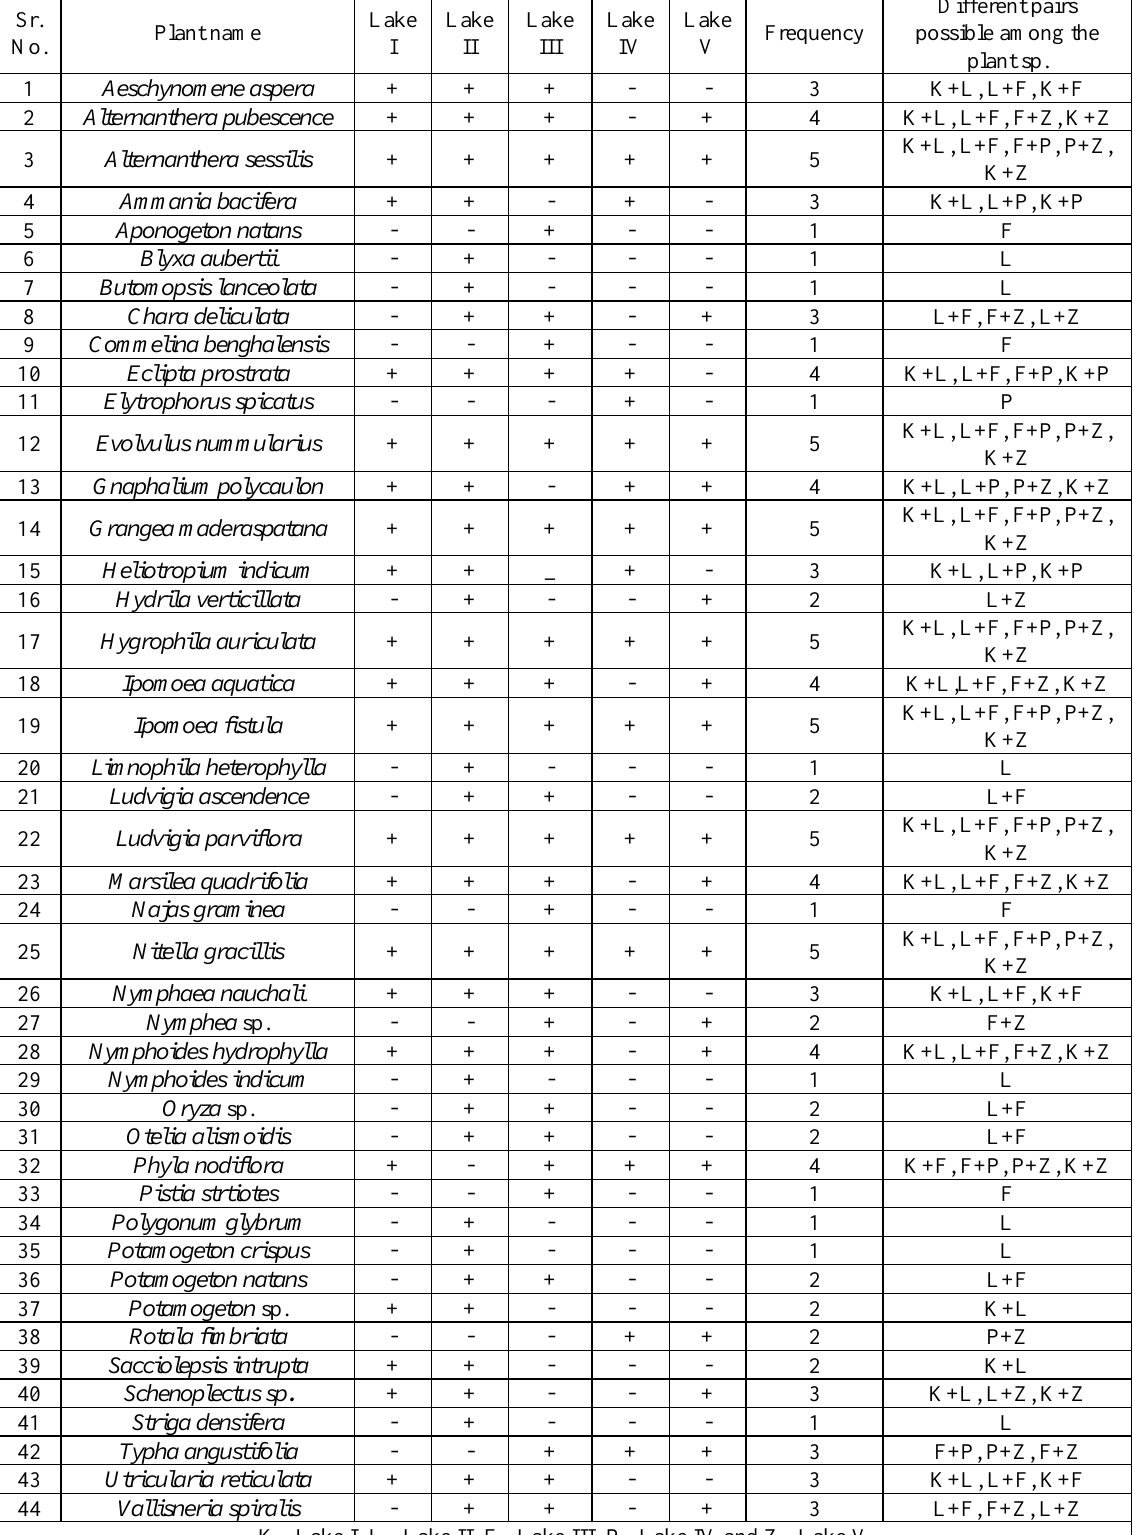
Table 4. Sitewise distribution of aquatic